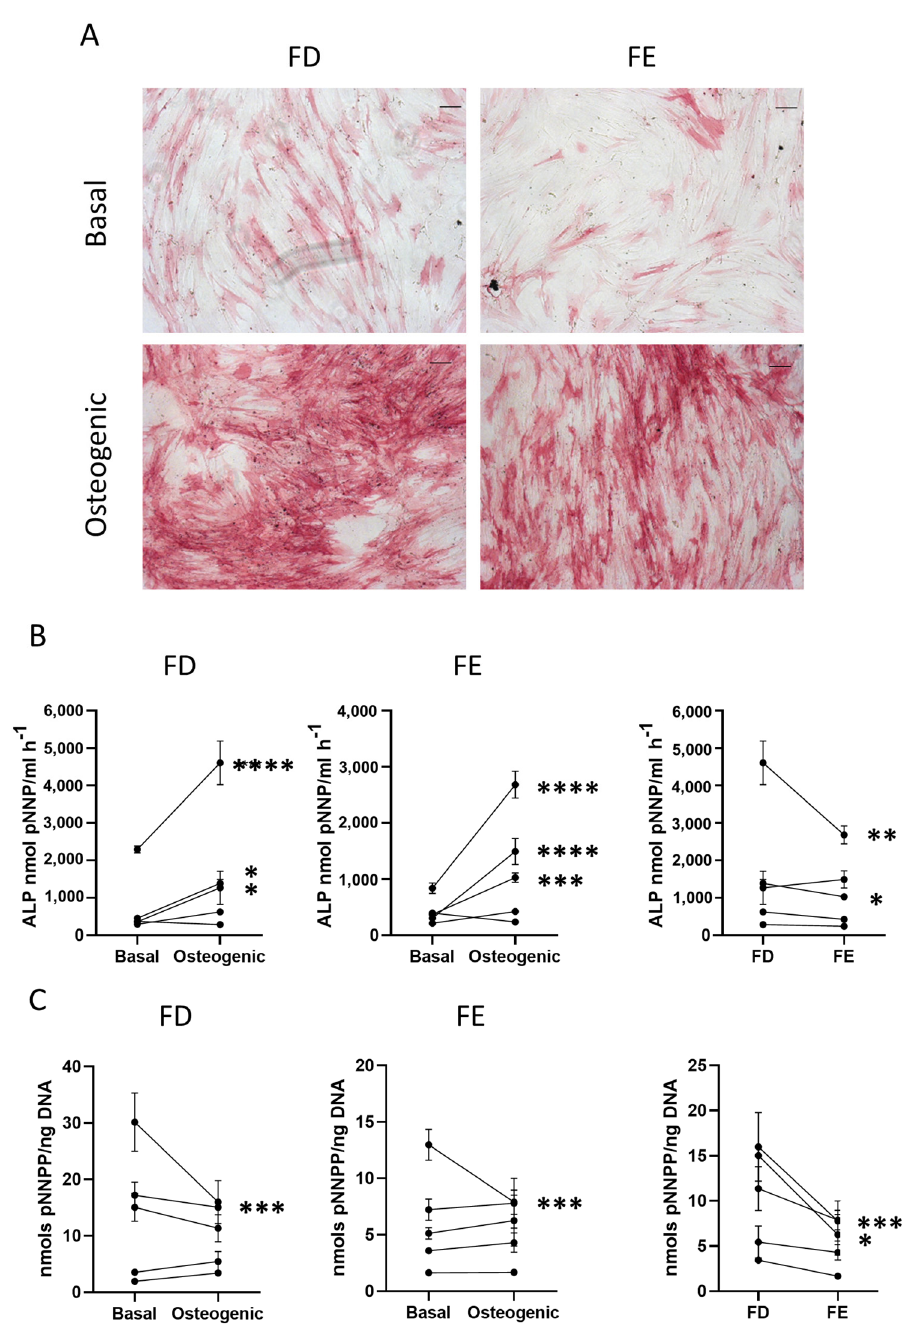
Figure 2. Early osteogenic differentiation of HBMSCs from two regions in the femur. ( A ) Representative images of ALP staining (pink/red) of HBMSCs from two femur regions, FD and FE. Cells were cultured in basal or osteogenic I media for seven days. Scale Bar= 100 µm. ( B ) ALP analysis of HBM- SCs, FD and FE. ( C ) ALP specific activity of HBMSCs, FD and FE. n = 5, symbols refer to individual patients with three technical replicates. Results presented as mean +/- SD, statistics analyzed using a one-way ANOVA, significance presented as * < 0.05, ** < 0.01, *** < 0.001, **** <